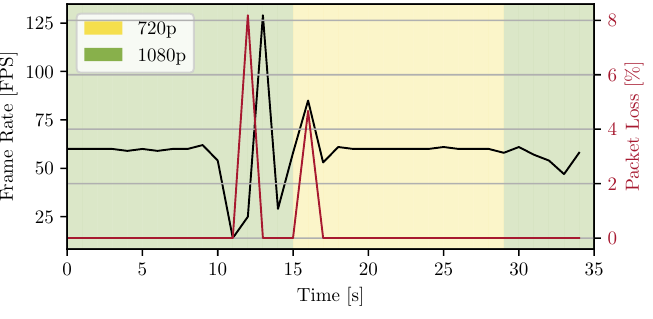
Figure 6. Example of quality-level reduction in Stadia , in terms of frame rate and video resolution subsequent to packet